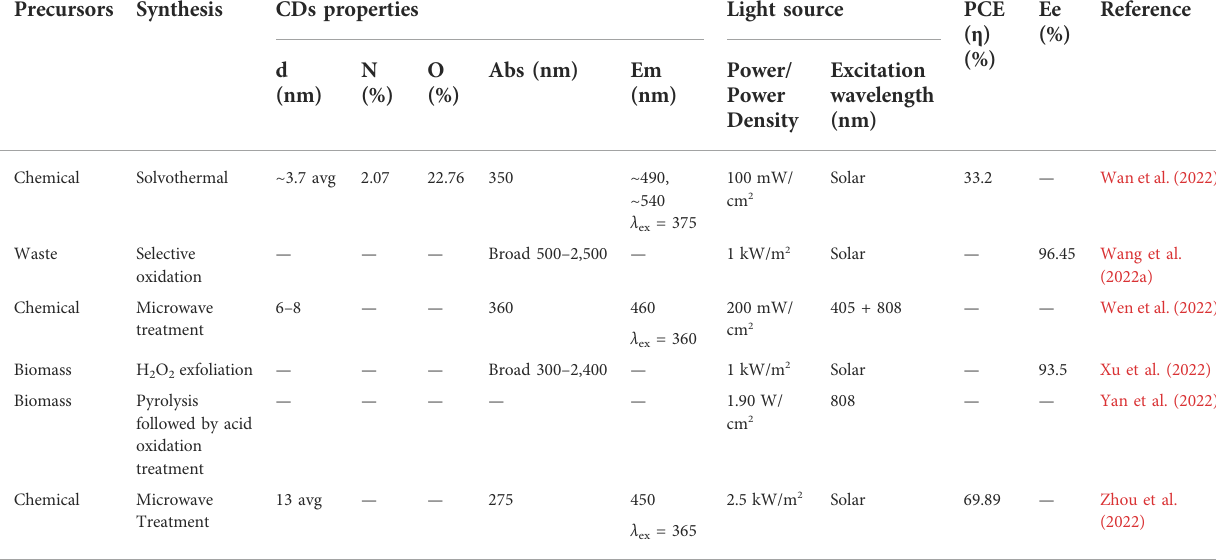
TABLE 1 ( Continued ) Photothermal application, synthesis protocol, properties, and PCE of carbon